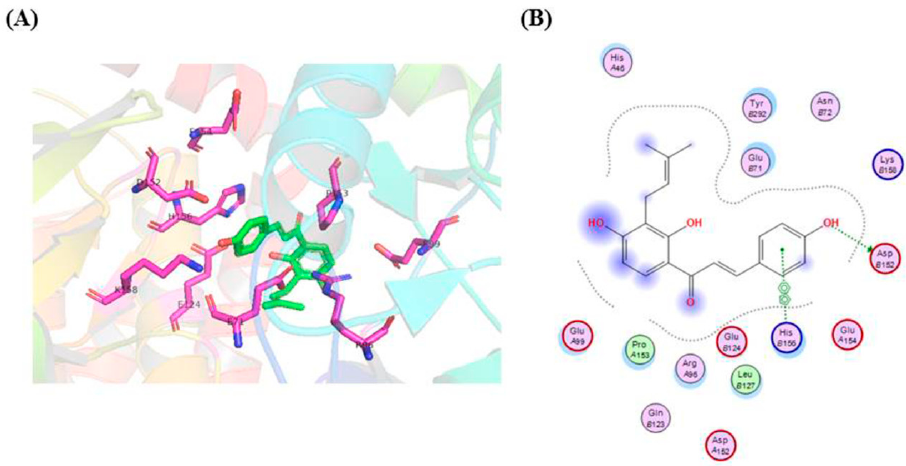
Figure 11. Molecular docking model of IBC in the active sites of the RIP3 protein. ( A ) Three-dimensional-binding models of IBC with RIP3. ( B ) A two-dimensional-binding model of IBC with RIP3.